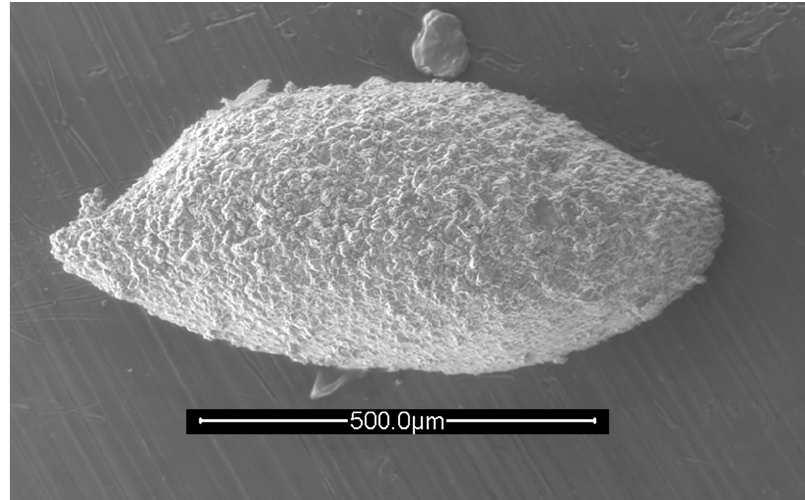
Figure 8. Rectobairdia sp. cf. R. legumen (Jones and Kirkby, 1886), left valve, lateral view. IGM 5011(5). Scanning electron micrograph (secondary electrons). Scale bar = 500 microns.